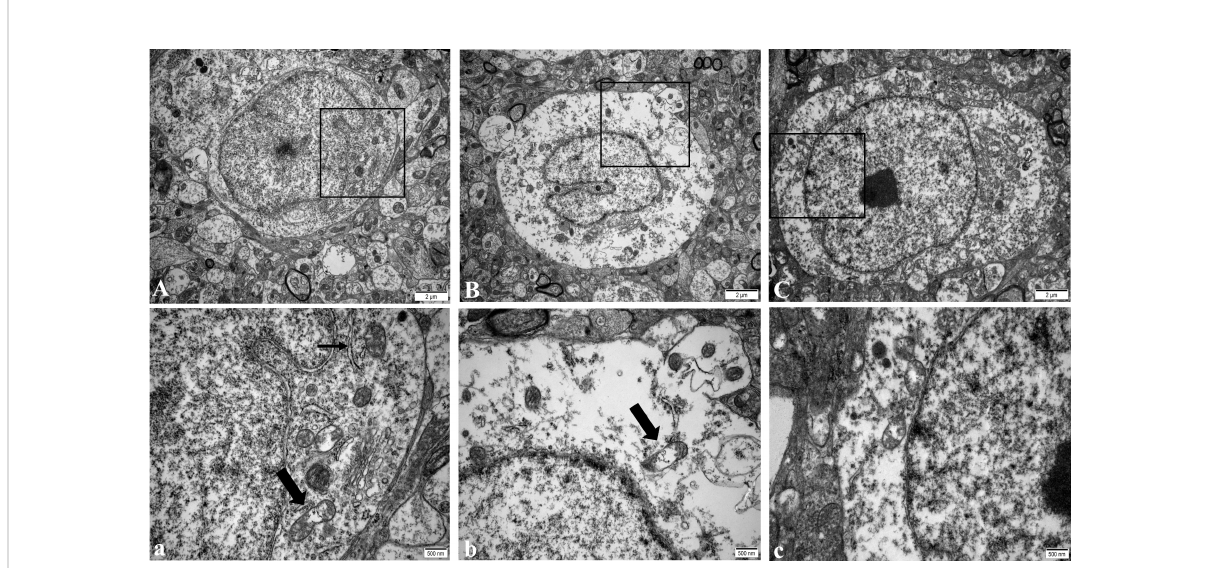
FIGURE 2 Ultra structure of hypothalamic neurons in male mice of NC group (A) , WD group (B) and DMSA GROUP (C) . The black rectangle corresponds to the local magni fi cation of each group of neurons (a – c) . In panel (a), the coarse arrow indicates mitochondria, and the thick arrow indicates rough endoplasmic reticulum. The arrow in panel (b) shows mitochondria with missing